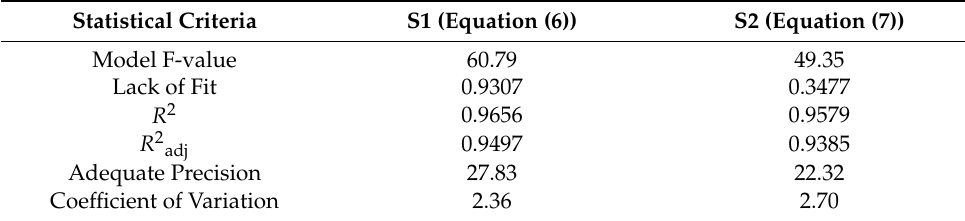
Table 3. Statistical information of the model fitting